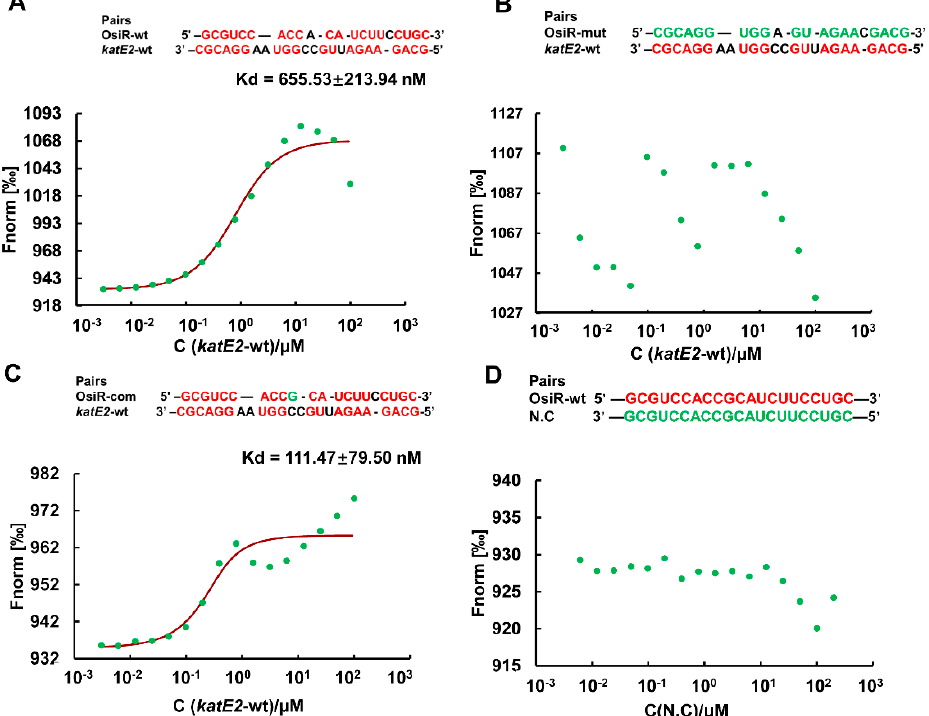
Figure 6. The binding affinity of OsiR to the katE2 mRNA by MST analysis in vitro. Pairing nucleotides are shown in red. Point mutations introduced into synthesized oligonucleotide derivatives are shown in green. The K d value reflects the binding affinity between two molecular fragments. wt: wild type; mut: mismatch mutation; com: compensatory mutation; N.C: negative control. (A) OsiR-wt/ katE2 -wt;